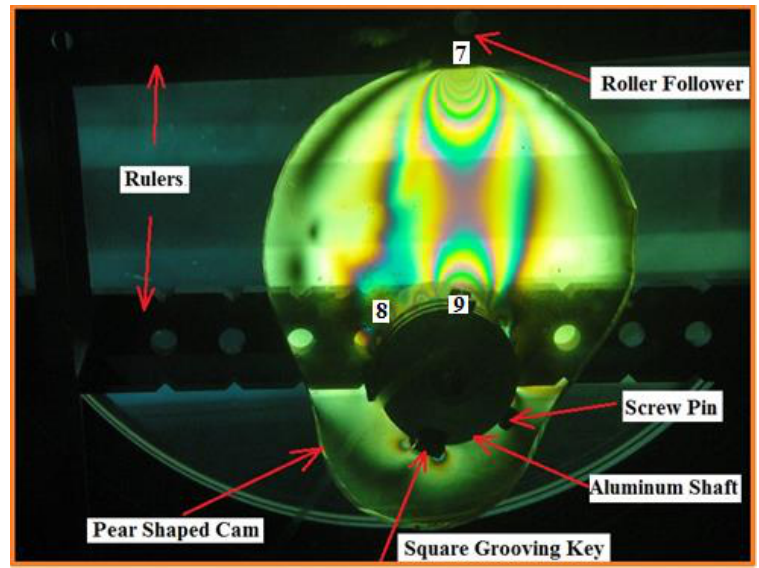
Figure 14. Experimental analysis of the stress distribution when the follower comes in contact with the base circle.